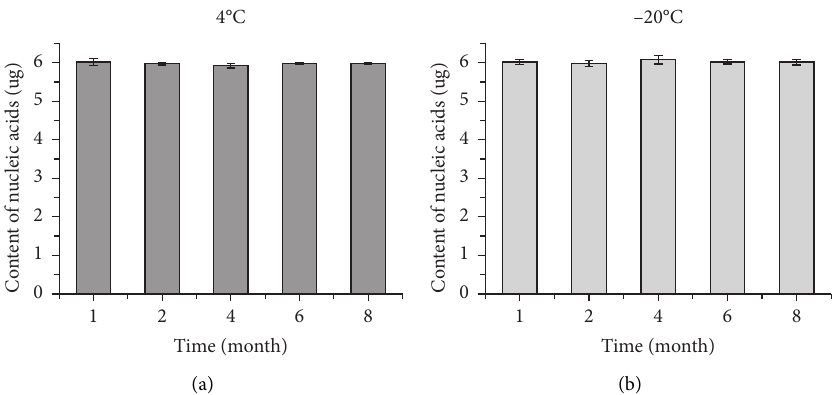
Figure 8: The long-term stability test of changes in 8 months of genomic nucleic acid reference material of C. sakazakii .